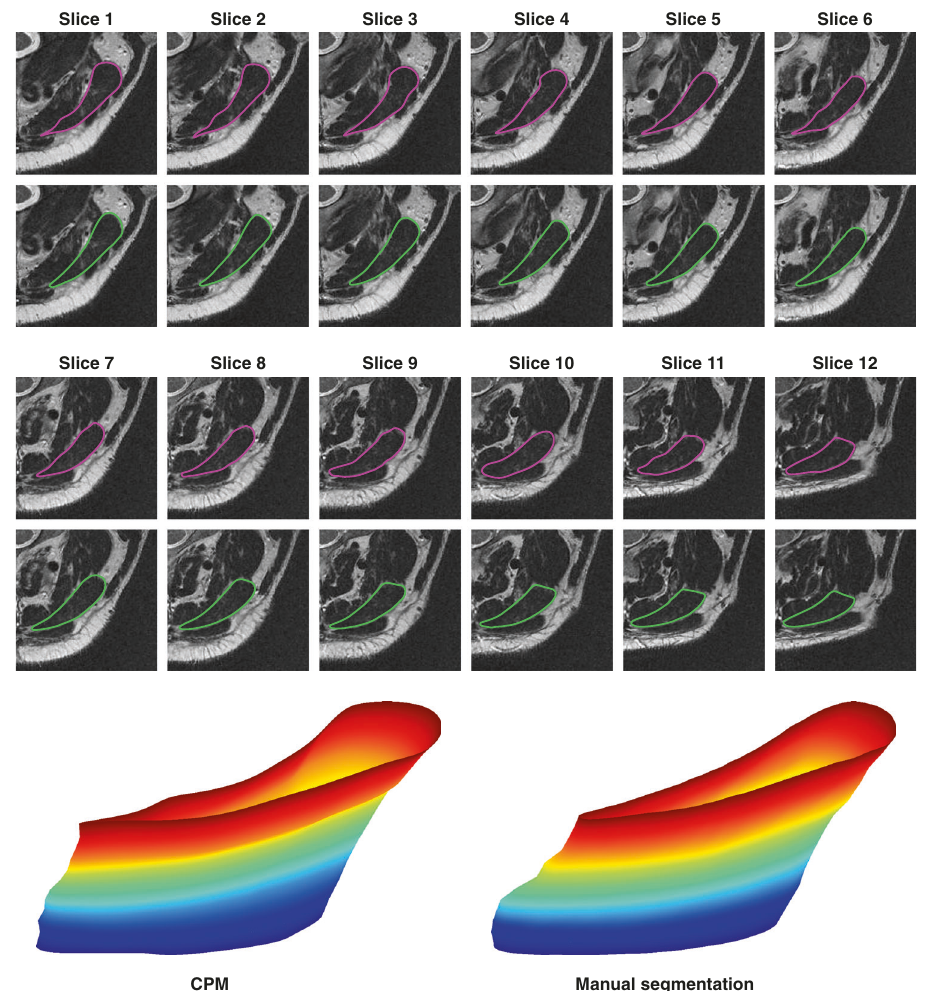
Fig. 9 Segmentations of 12 consecutive magnetic resonance images of splenius capitis and reconstructions of the three-dimensional structure. Magenta curves in the images represent the fi nal contours obtained by the crack-propagation method and green curves denote the manual segmentation boundaries. The red area of the three-dimensional structure corresponds to the fi rst-layer image close to the head and the blue area corresponds to the last-layer image close to the